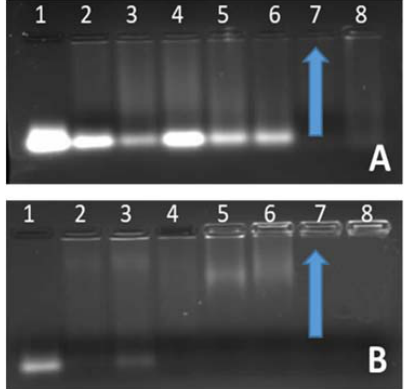
Figure 3. Agarose gel electrophoresis showing complexing of siRNA to nanoparticles: ( A ) SeCh and ( B ) SeChFA. Lane 1: siRNA (0.5 µ g), Lanes 2–8: 0.5 µ g siRNA and varying amounts of NP ( A ) SeCh (0.5, 1, 1.5, 2, 2.5, 3, and 3.5); ( B ) SeChFA (0.4, 0.5, 1, 2, 3, 4, and 5). Arrows indicate end-point / optimum binding w / w ratios.